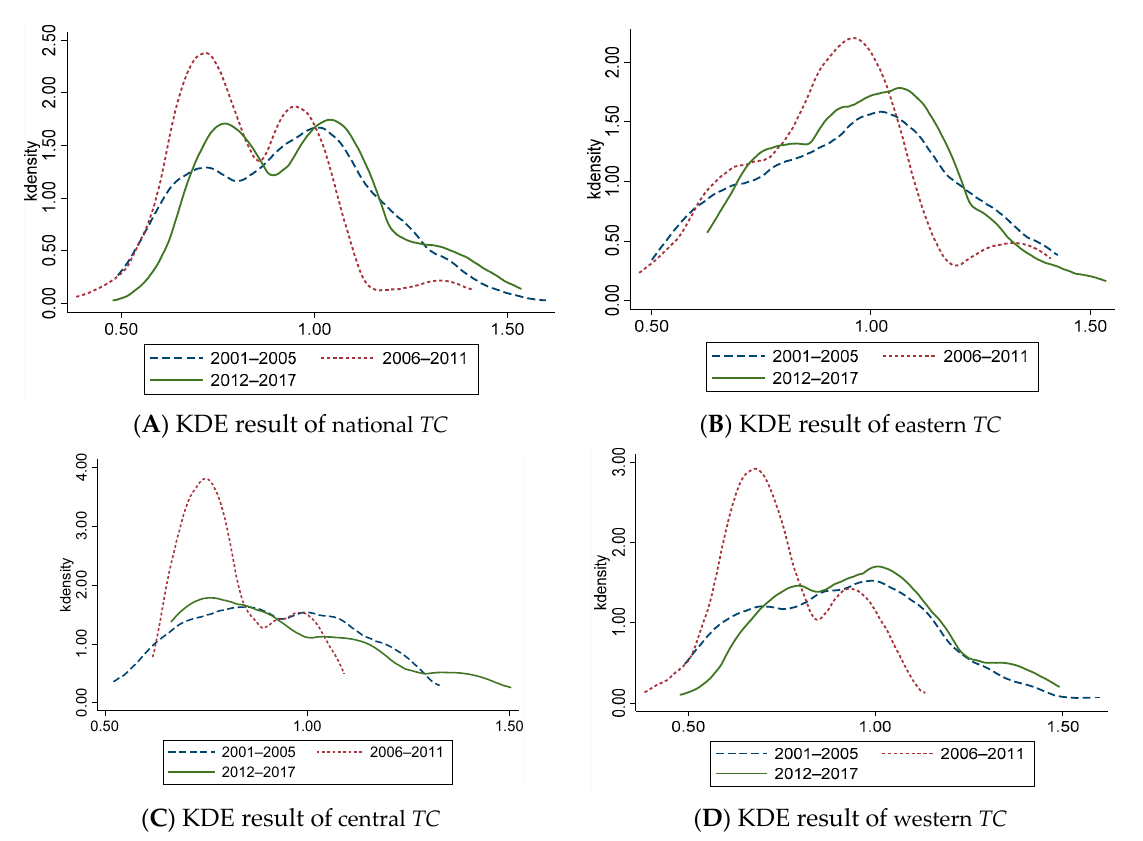
Figure 3. The Kernel Density Estimation Results of Technical Change of China’s Logistics Industry. ( A ) KDE result of national TC ( B ) KDE result of eastern TC ( C ) KDE result of central TC ( D ) KDE result of western TC